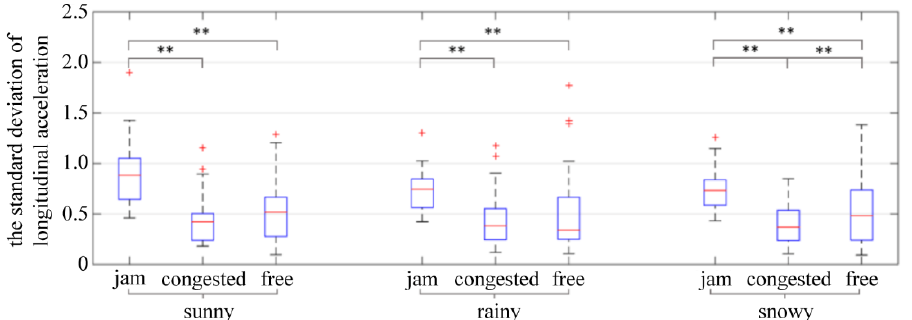
Figure 13. The standard deviation of longitudinal acceleration. ** indicates the variable was statistically significant at 0.05 level. + indicates outlier.